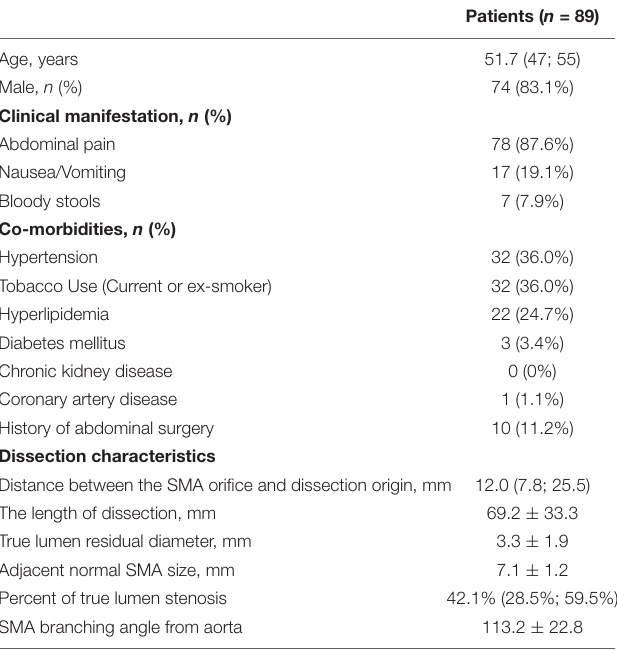
TABLE 1 | Demographic data and clinical features of patients with